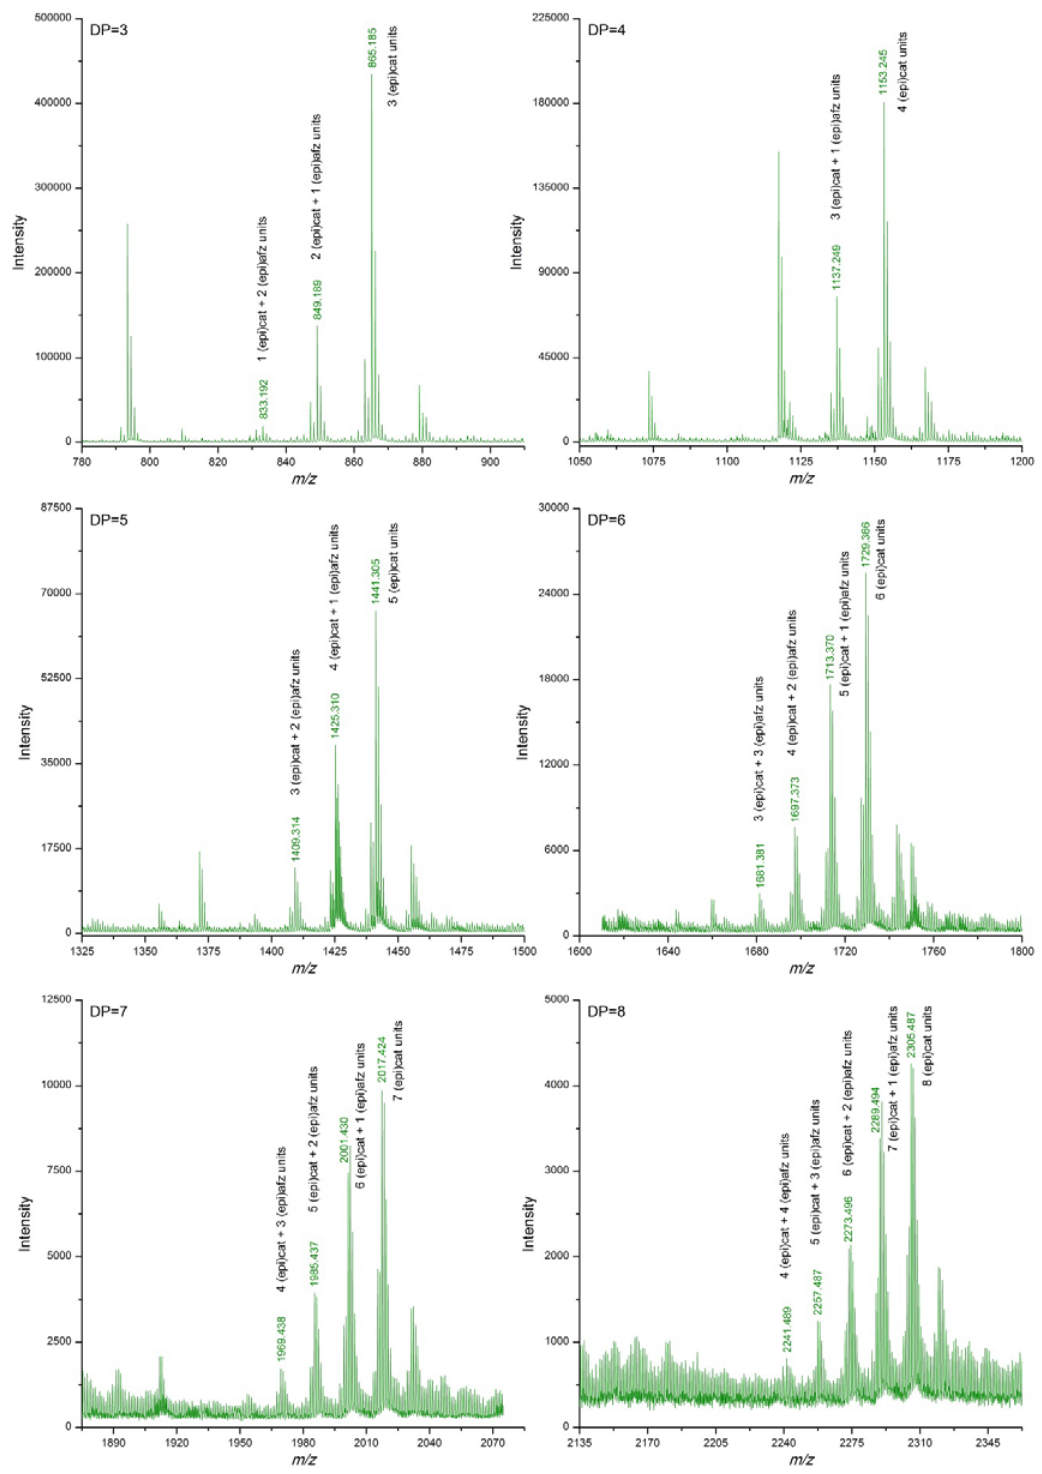
Figure 4. Enlargements of DI-ESI-QTOF mass spectrum of proanthocyanidins with DP 3–8 from a sample of U. tomentosa bark from Sarapiquí location.